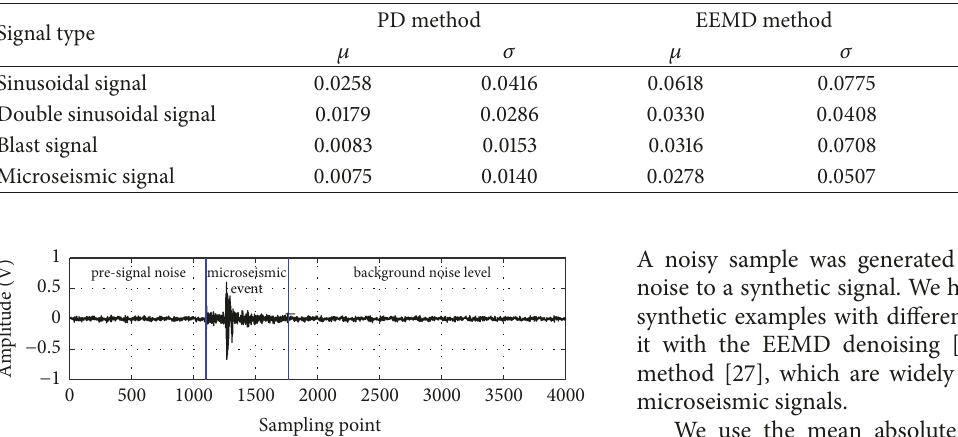
Table 1: Comparison of signal denoising indicator with different types.